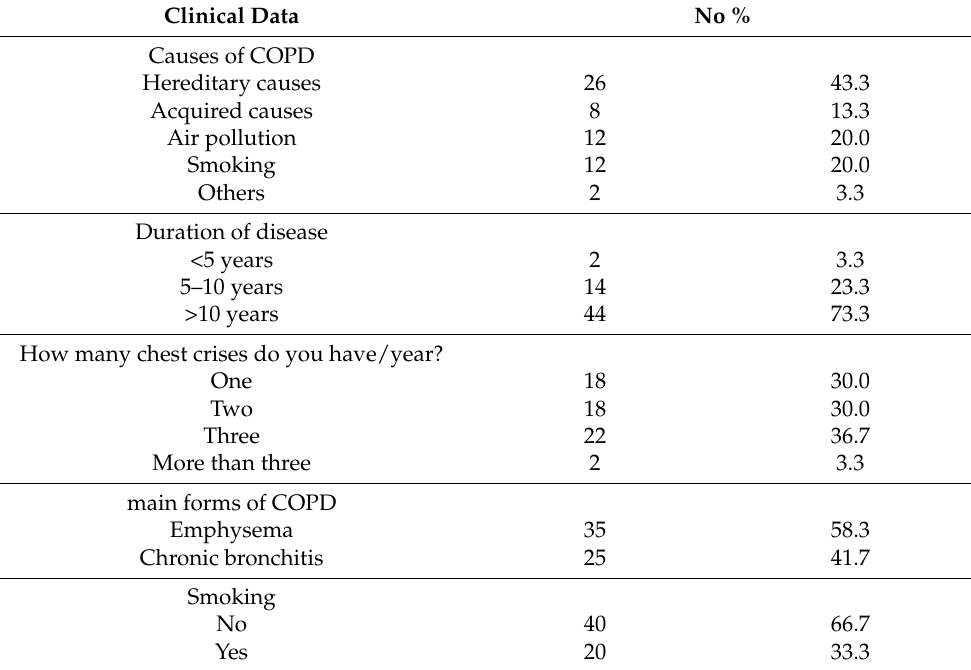
Table 2. Distribution of the studied patients according to their clinical data (n =